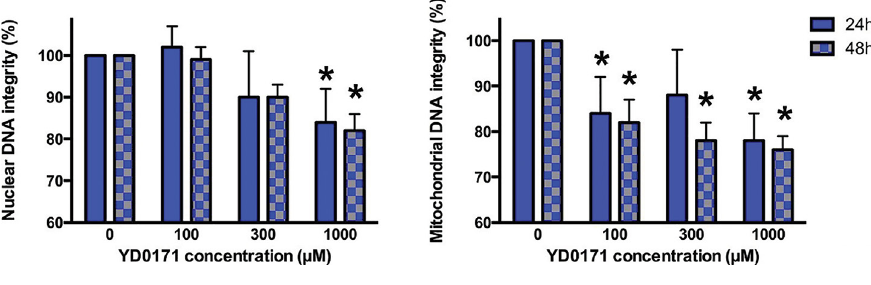
Figure 12. Effect of YD0171 on mitochondrial and nuclear DNA integrity in HCT116 cells. Cells were treated with YD0171 (100, 300 or 1 mmol/L) or AOAA (100, 300 or 1 mmol/L) for 48 h, followed by LA-PCR assays. * p < 0.05 and ** p < 0.01 indicate significant reduction in DNA integrity compared with control. Data are shown as mean ± SEM; n = 6.